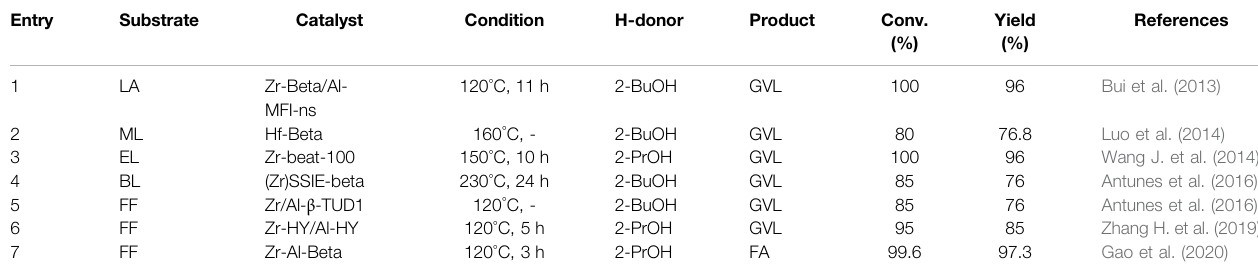
TABLE 3 | Zr/Hf-containing zeolite catalysts.